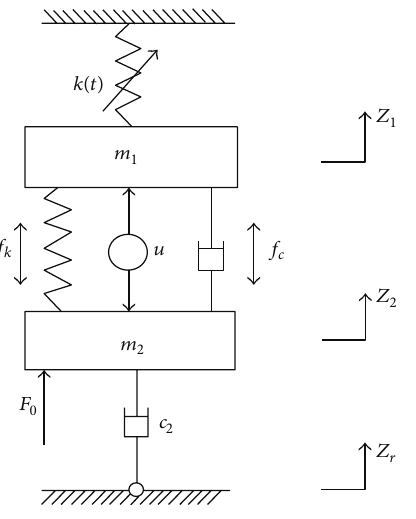
Figure 3: A simplified pantograph-catenary interaction